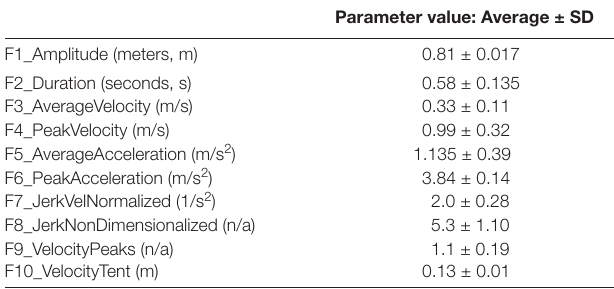
TaBle 2 | Basic kinematic parameters; F = Feature.